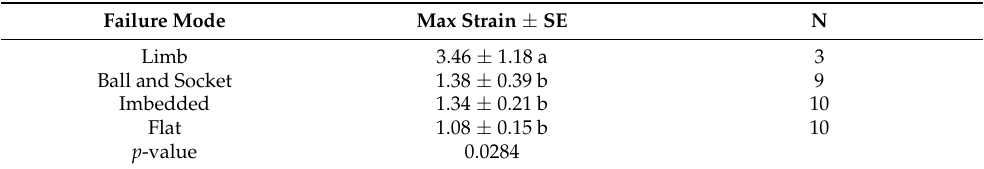
Table 2. Mean overall max strain ± SE and ( n ) for each failure mode. Mean with different letters in the column were found to be significantly different using Tukey HSD. Data were analyzed using Log 10 but untransformed (original scale) means and SE are used for presentation purposes.